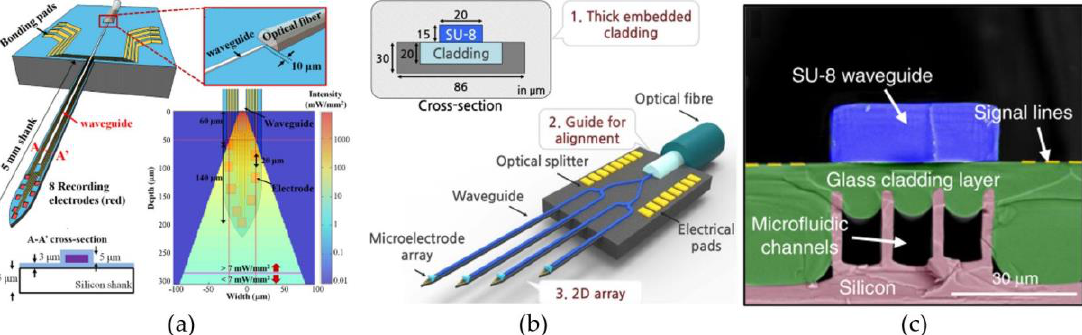
Figure 3. Optrodes constructed with waveguides on Michigan-type neural electrodes. ( a ) An optrode consisting out of an oxynitride waveguide and eight electrical recording sites on top of a 15-µm-thick silicon substrate. The light is coupled into the waveguide by an optical fiber positioned in a U-groove at the proximal end of the probe. For 7 mW of 473 nm light inside the optical fiber, the simulation results show the light-power densities that can be achieved in the neural tissue at the distal end of the waveguide. Reproduced with permission from [122]; published by IOP, 2013. ( b ) A four-shank waveguide-based optrode, constructed using two levels of y-shaped optical splitters. The SU-8 waveguide is accompanied by a low-stress, glass cladding layers created with a reflow process. Reproduced with permission from [87]; published by Nature, 2015. ( c ) Cross-sectional image of the glass cladding layer with incorporated microfluidic channels. Reproduced with permission from [125]; published by Nature,